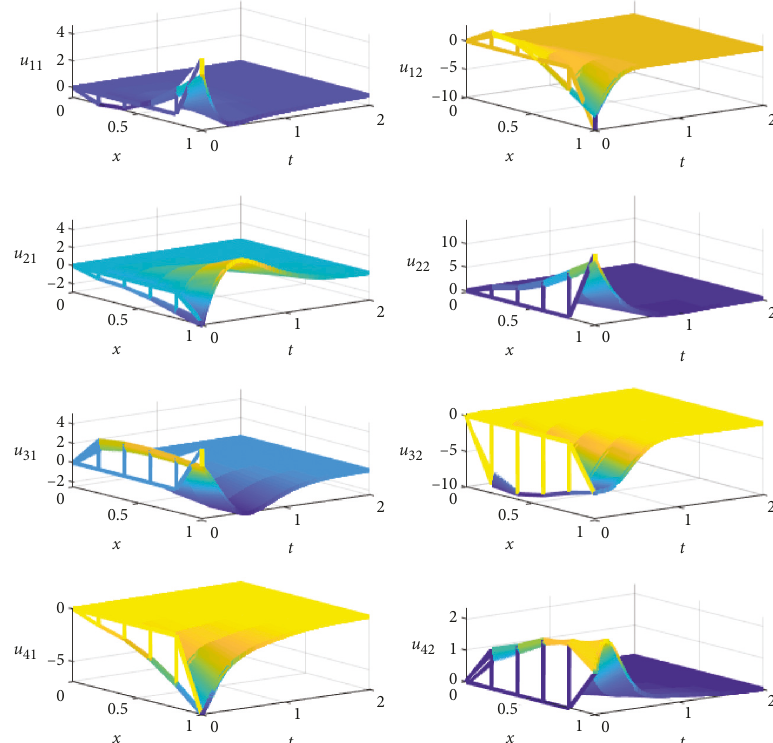
Figure 3: The profile of u